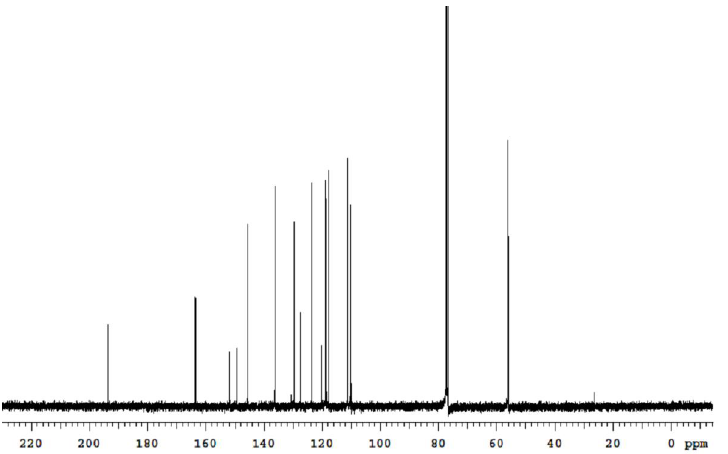
Figure 3. 13 C NMR Spectrum of 2'-hydroxy-3,4-dimethoxy